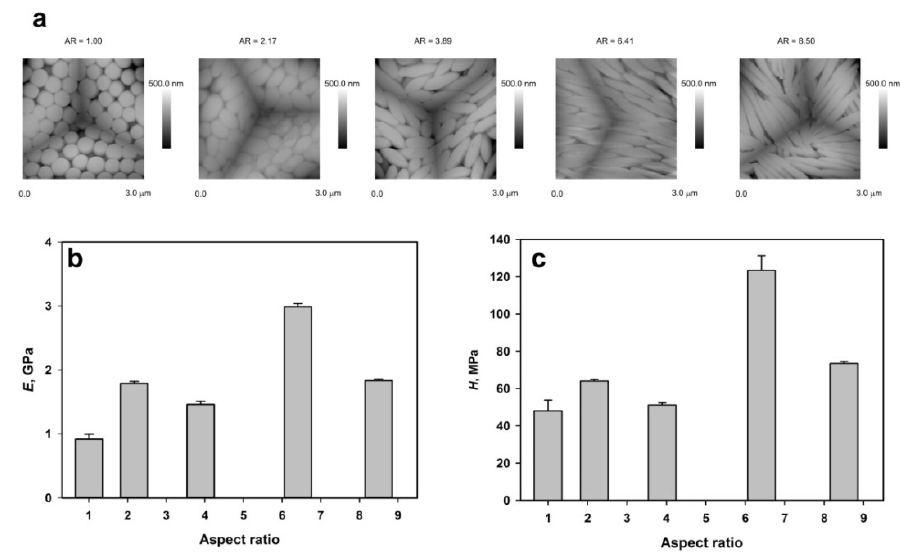
Figure 10. Mechanical properties of assemblies of microparticles determined using Berkovich nanoindenter; ( a )—imprint of nanoindenter in assembly of microparticles, ( b )—relation between modulus of elasticity and aspect ratio of microparticles, ( c )—relation between hardness and aspect ratio of microparticles. Plots were prepared using the number average and standard deviation values.